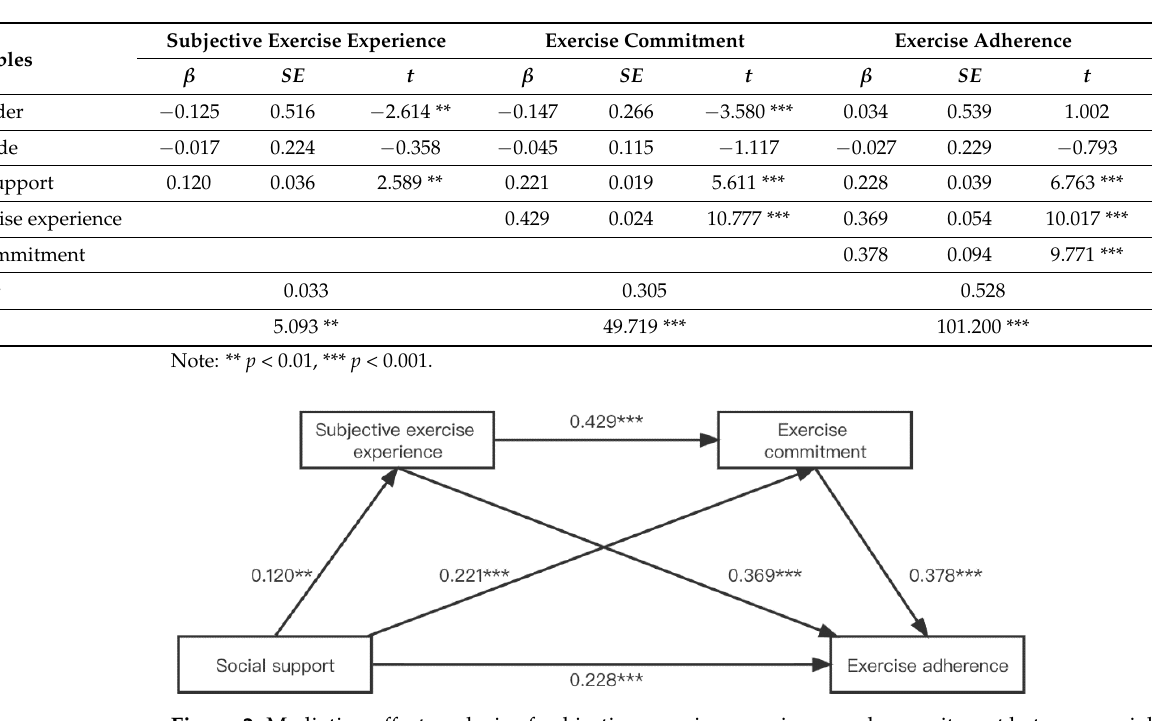
Figure 2. Mediation effect analysis of subjective exercise experience and commitment between social support and exercise adherence; *** p < 0.001, ** p < 0.01.